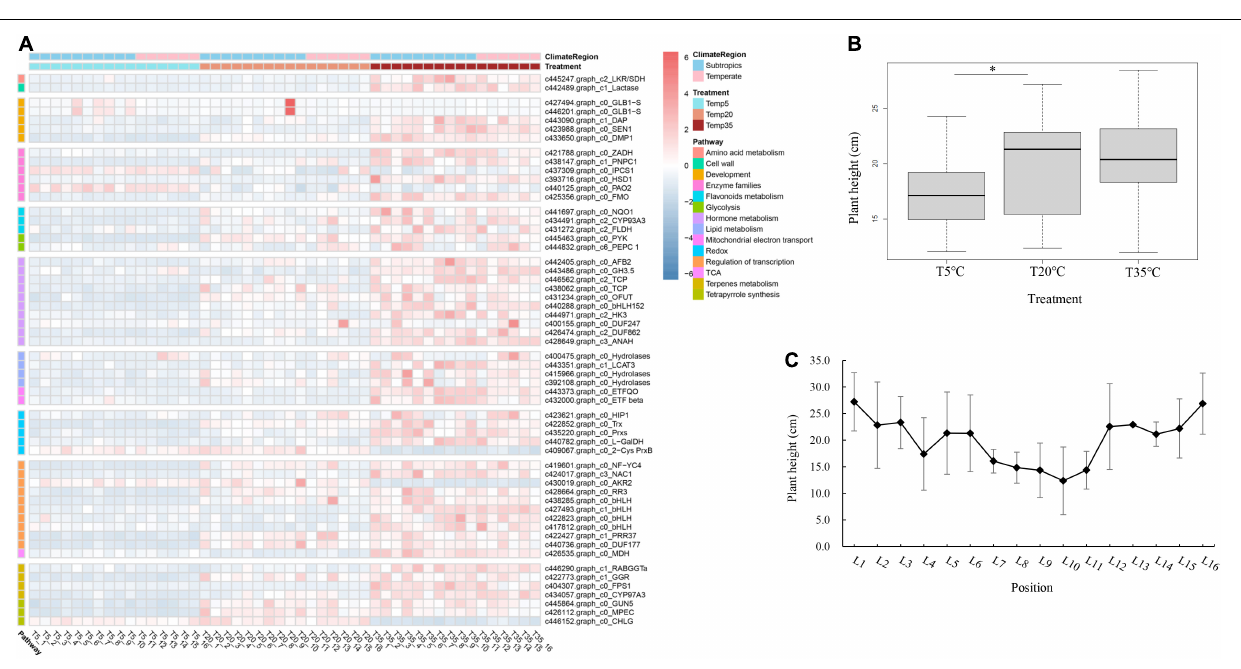
FIGURE 4 | Analysis of key DEGs from related modules with plant growth and development in bermudagrass. (A) Heatmap of DEGs from related functional pathways in different bermudagrass samples and treatment groups (T5, T20, and T35). (B) Boxplot of plant height of bermudagrass materials from different latitudes after different temperature treatments. The bold black line in the box represents the median, and the asterisk ( ∗ ) indicates significant difference ( p < 0.05). (C) The plant height of the group of T20 treatment from different positions. The full name or annotation of all gene abbreviations in the study was shown in